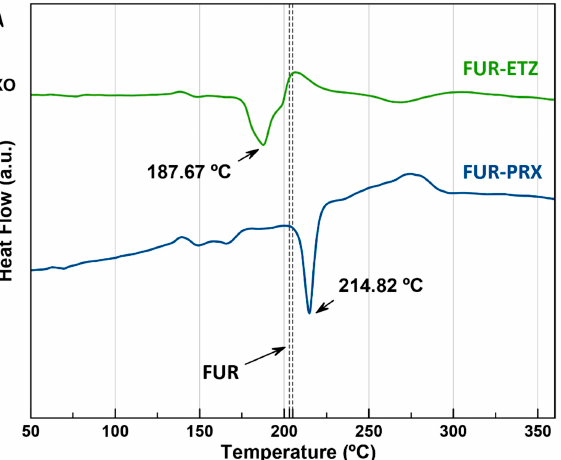
Figure 6. Differential scanning calorimetry (DSC) plots of FUR–ETZ and FUR–PRX. Dotted lines correspond to the range of temperature reported for melting of FUR.